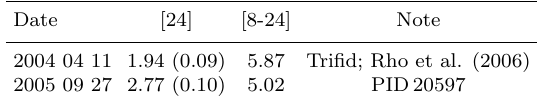
Table 4. Spitzer -MIPS photometry of V2282